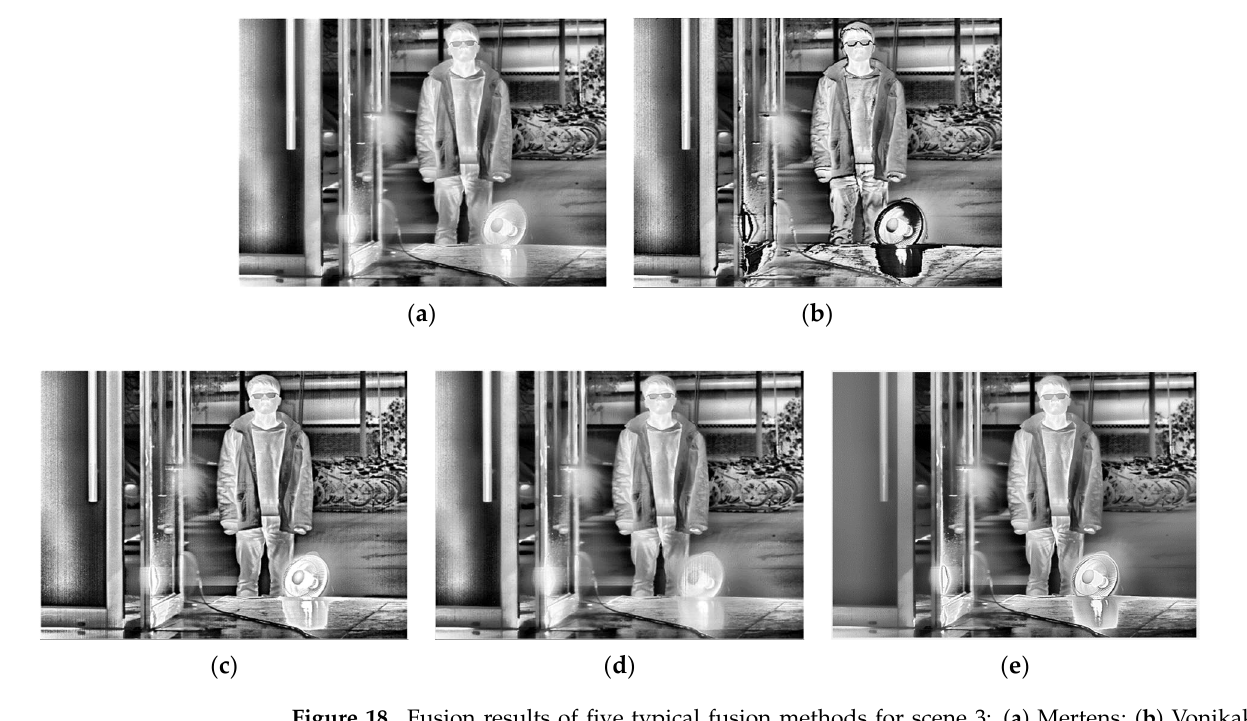
Figure 18. Fusion results of five typical fusion methods for scene 3: ( a ) Mertens; ( b ) Vonikakis; ( c ) Ma; ( d ) Kou; ( e ) MIF&DE.